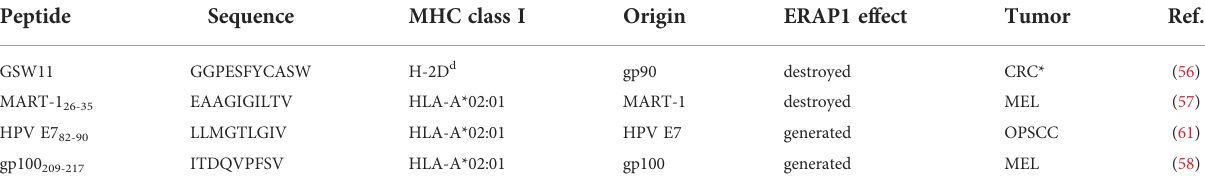
*CRC, colorectal carcinoma; MEL, melanoma; OPSCC, oropharyngeal squamous cell